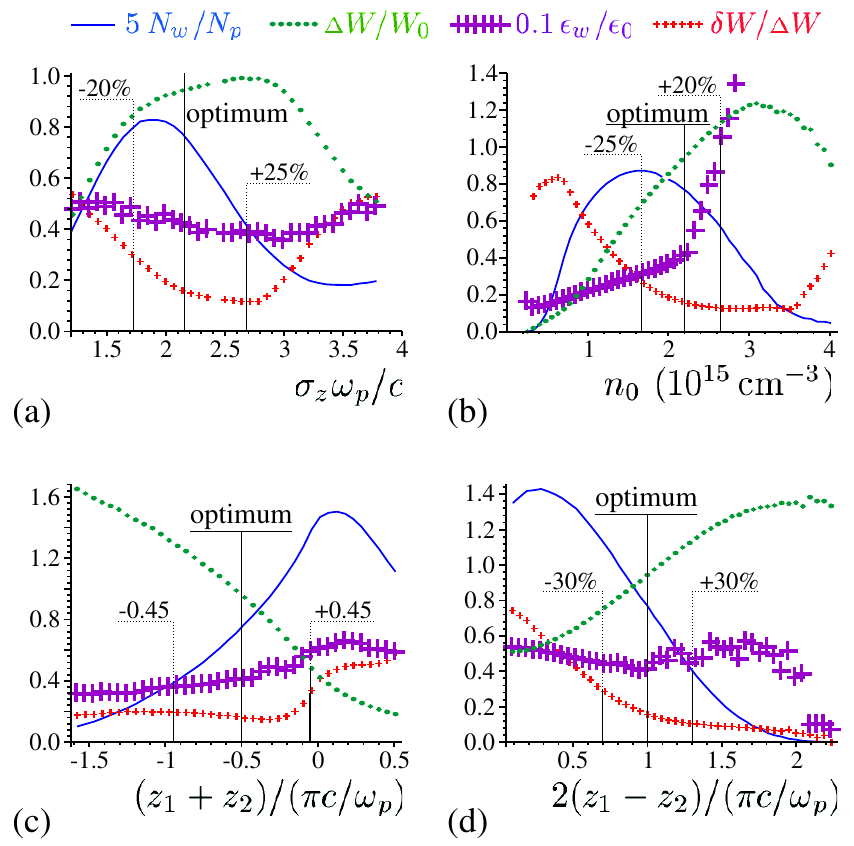
FIG. 8. (Color) Variation of the witness population N length, (b) plasma density, (c) cut-out location, and (d) cut-out width deviate from the optimum